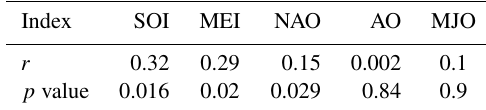
Table 1. Correlation coefficient ( r ) and p value between precipita- tion at Mehrabad station and different teleconnection